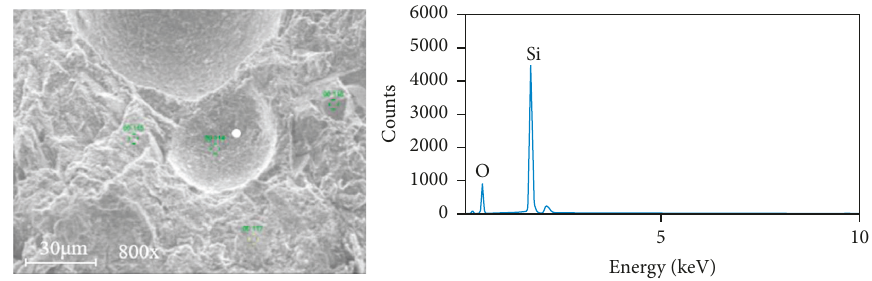
Figure 11: EDS images (scale bar 30 μ m).